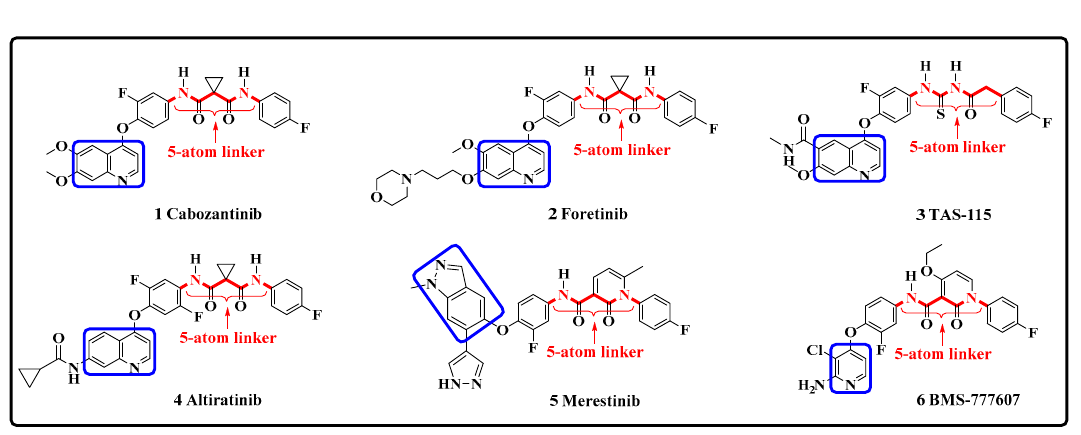
Figure 1. The representative small-molecule c-Met kinase inhibitors.